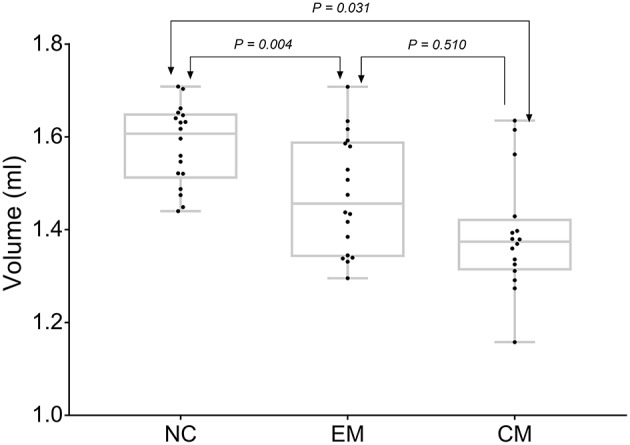
HTH volume distribution plot of NC, EM and CM patients.